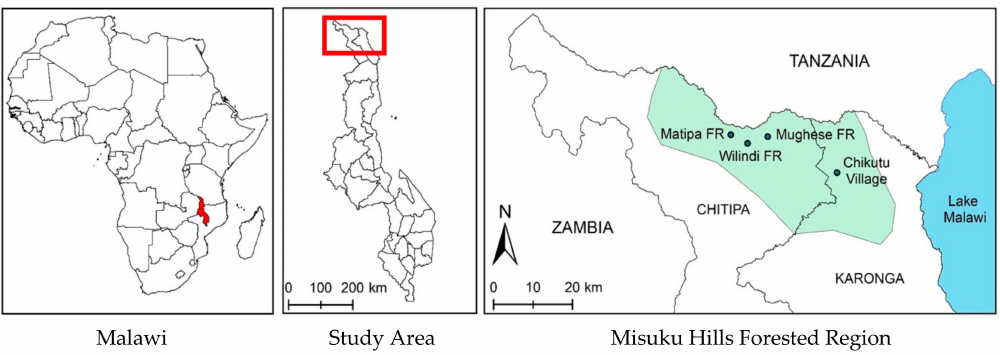
Figure 2. Location of the Misuku Hills forested region (MHFR) study